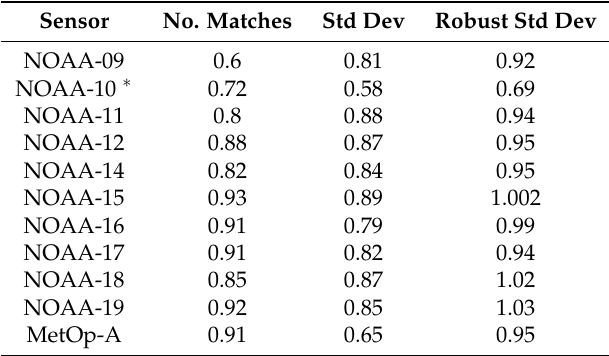
Table 9. Ratio of three-channel (3.7, 10.8 and 12 µ m) nighttime SST retrieval statistics using Bayesian and CLAVR-x cloud masks compared against GTMBA data. Ratios are calculated using satellite minus in situ SST differences, first applying the Bayesian mask and then comparing against the same statistics with the CLAVR-x mask applied. Values less than one in each column indicate that the Bayesian mask has fewer matches, lower standard deviation or lower robust standard